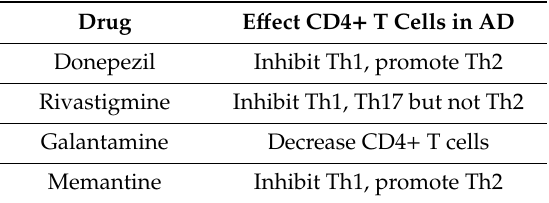
Figure 5. The effect of known AD drugs on CD4+ interaction with the BBB in AD. While donepezil, rivastigmine, and memantine are capable of inhibiting Th1, only rivastigmine was reported to inhibit Th17. Galantamine could inhibit proliferation of CD4+ T cells; however, its specificity towards CD4+ T cell subpopulations is still obscure. Nevertheless, all four drugs are capable of decreasing adhesion of CD4+ T cells to the surface of endothelial cells through downregulating ICAM1. They are also capable of decreasing astrocytes activation. However, their ability to target astrocytes Th17 interaction is still open for investigation. Table 7. E ff ect of Drugs on CD4 T cells proliferation and